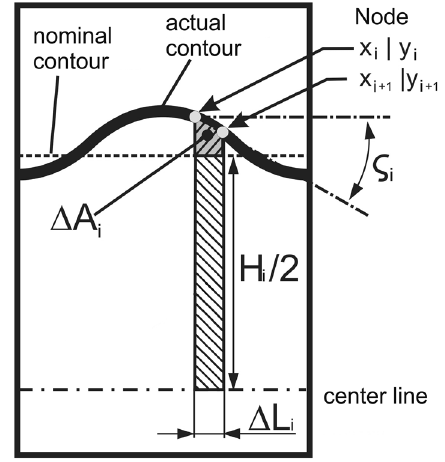
Fig. 3 Quantification of wrinkles Kuhnhen